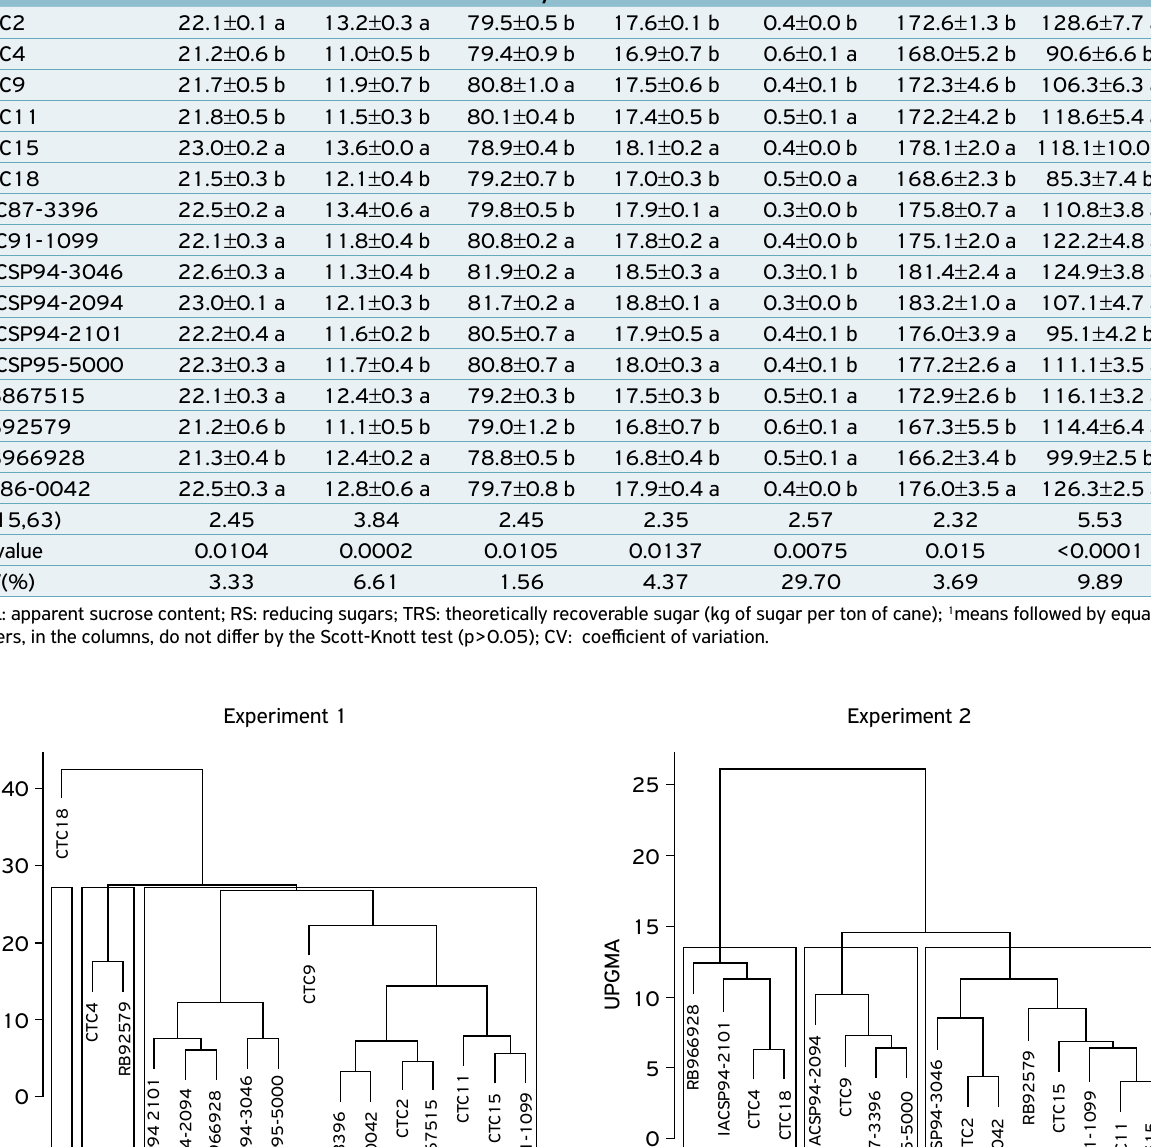
Table 4. Parameters of technological quality and yield of 16 sugarcane cultivars: experiment 2. Goianésia, GO, Brazil, 2012. Technological quality Cultivar 1